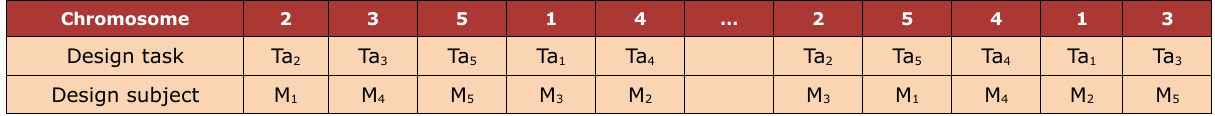
Table 2. Corresponding relationship of chromosome, design task and design subject